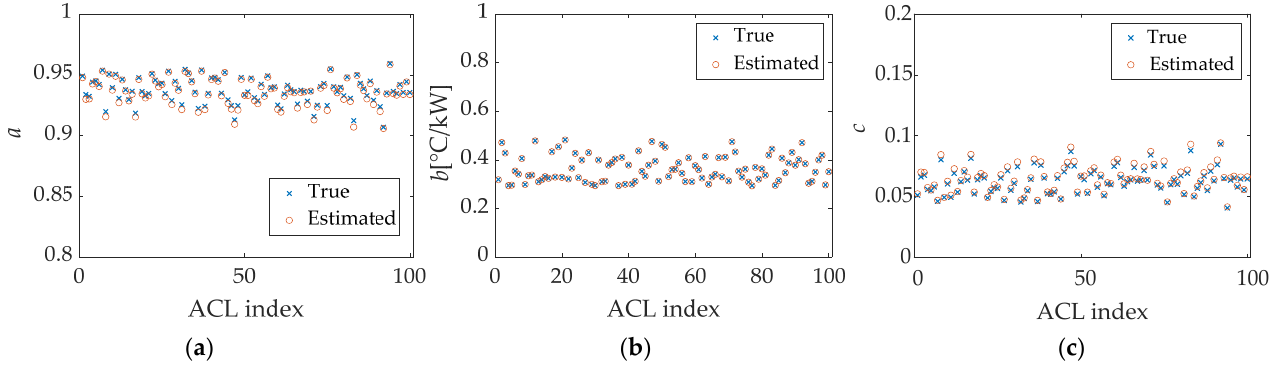
Figure 4. Estimated and true model parameters . ( a ) Comparison of a . ( b ) Comparison of b . ( c ) Comparison of c.